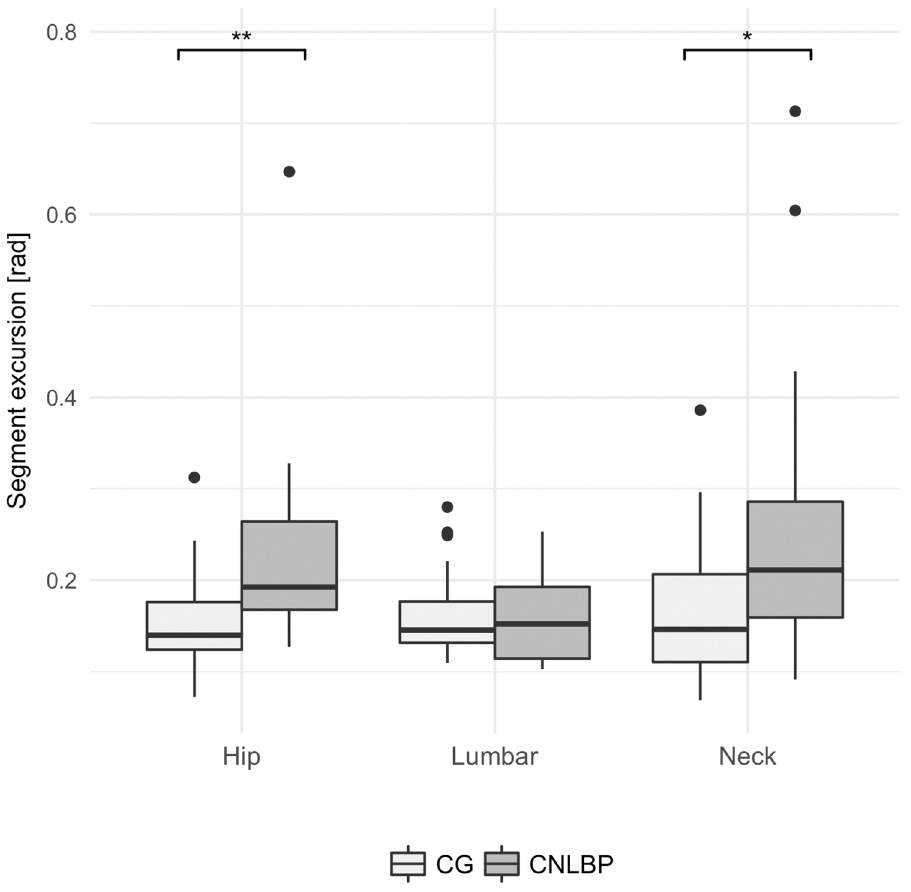
Fig 6. Group comparison of segmental angle excursions. Distribution of the angle excursions of the investigated segments with highest PCA loading. Across trial average values computed for the first second of the active response phase. (cid:3) P < .025; (cid:3)(cid:3) P <